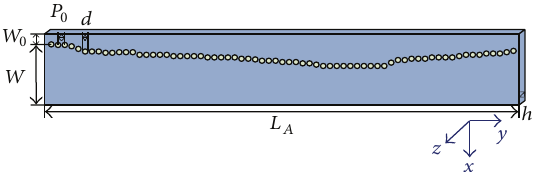
Figure 7: Structure of the designed low SLL HMSIW LWA.